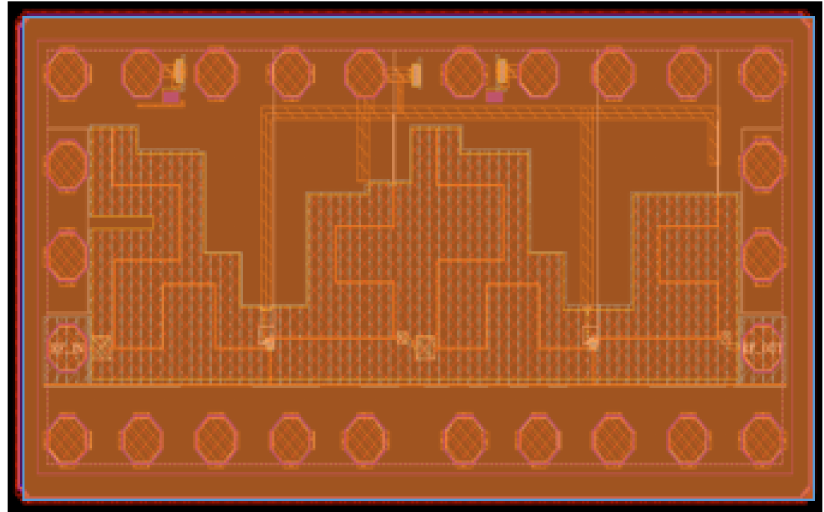
Figure 12. Layout of the two-stage LNA. The characteristics of the LNA were validated by simulating two-port S-parameters from a frequency of 20–44 GHz. The simulated input reflection coefficient ( S 11 ) and output reflection coefficient ( S 22 ) are shown in Figure 13. S 11 and S 22 of < − 10 dB were achieved from a frequency of 20–44 GHz with a 50 Ω source and load impedance. The simulated NF (Noise Figure) is as shown in Figure 13, and IP1dB (input 1 dB gain compression point) [17,18] is shown in Figure 14; they were 3.42 dB and − 18 dBm, respectively. In Figure 13, the simulated gain appears greater than 20 dB from 20–44 GHz. The reverse isolation ( S 12 ) of the presented LNA was < − 65 dB, as shown in Figure 13.